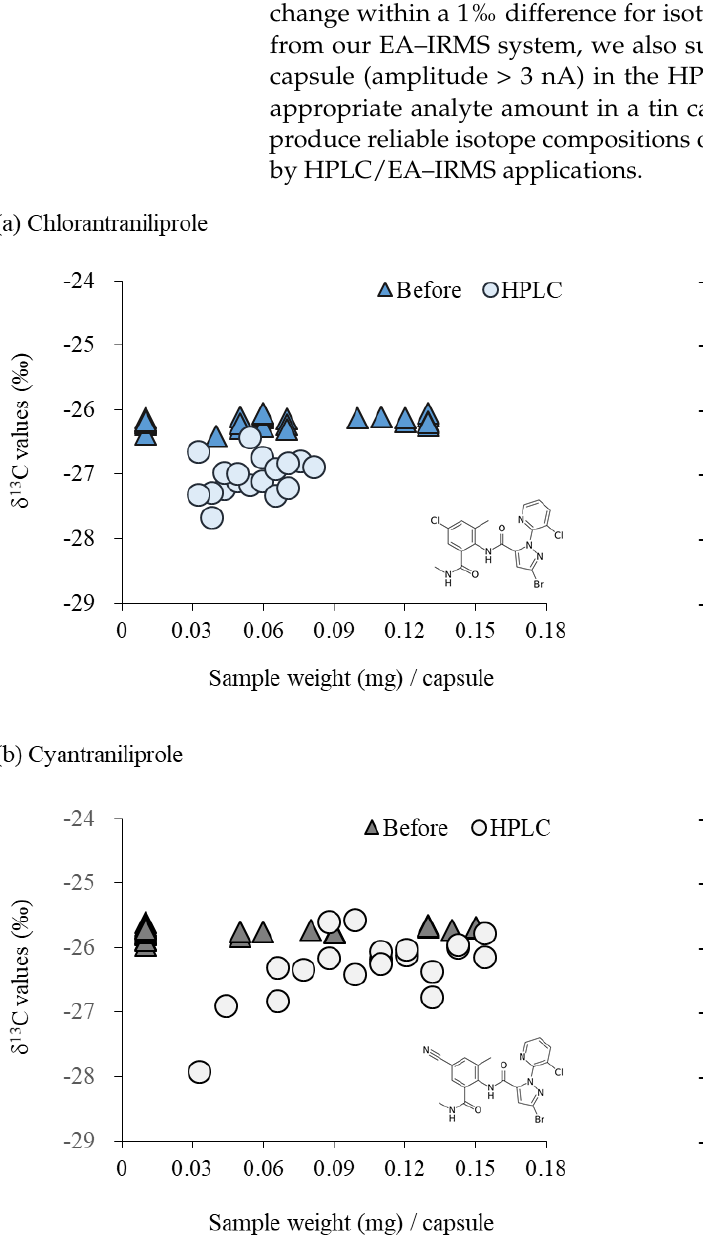
Figure 3. Effects of HPLC analytic procedure on determining isotope measurement in CHL standard ( a ) and CYN standard ( b ).